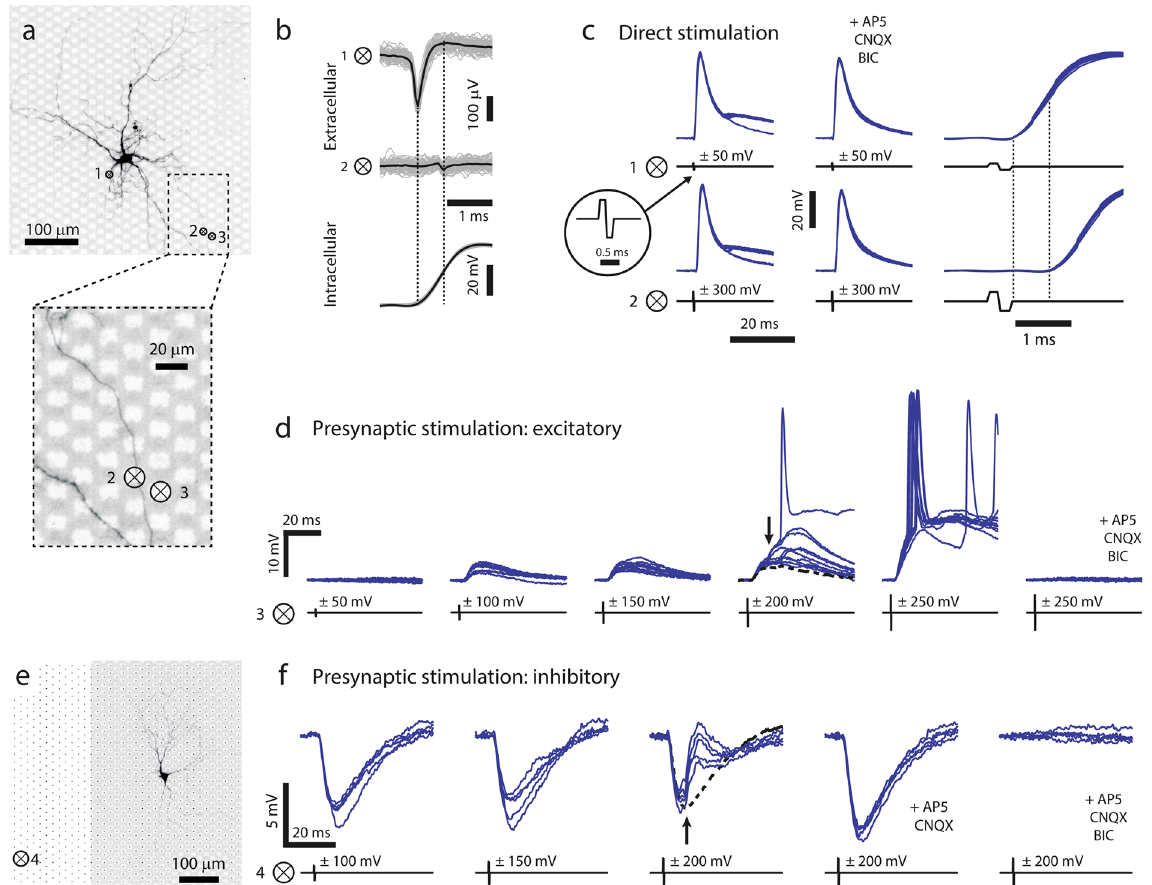
Figure 6. Evoking postsynaptic signals through HD-MEA electrical stimulation. ( a ) Fluorescence image of a neuron patched on the array, the numbered crosses inside circles “ ⊗ ” indicate positions of stimulating and/ or recording electrodes. The magnified part at the bottom shows that a neuronal process is situated on top of electrode 2 . ( b – e ) Numbered ⊗ correspond to the electrodes indicated in a. ( b ) STA extracellular traces (gray) and average trace (black), measured at electrodes 1 and 2 ( top ) and intracellularly measured AP ( bottom ). Note differences in spike shape and the temporal delay between the waveforms at electrodes 1 and 2 . ( c ) Left: Intracellular responses (blue traces, 10 trials each) to extracellular stimulation at electrodes 1 and 2 under control conditions. The stimulus timing is indicated by the black traces, and the inset shows a single biphasic voltage pulse. All stimuli evoked APs, some stimulation trials also evoked PSPs, which overlapped with the APs. Center : Responses in the presence of synaptic blockers, where no PSPs were evoked. Right : Zoom-in on responses under control conditions to better visualize the delay between stimulus end and AP onsets (depicted by the dashed lines). Also note the difference in stimulus amplitude required to elicit an action potential through electrodes 1 and 2 . ( d ) Stimulation with voltage pulses of increasing amplitudes. APs of a presynaptic neuron were evoked with stimulation voltages of ± 100 and ± 150 mV leading to PSPs. Increasing the voltage to ± 200 mV resulted in additional PSPs for some trials (indicated by the black arrow, the dashed black line represents the median response for ± 150 mV pulses). Yet larger PSPs were seen for ± 250 mV, along with the occurrence of postsynaptic APs in most of the trials. Addition of synaptic blockers resulted in complete blockade of evoked signals, indicating that all observed responses involved synaptic transmission. ( e ) Fluorescence image of another neuron and position of the stimulation electrode 4 . Black dots represent the positions of MEA electrodes. ( f ) PSPs upon stimulating an inhibitory presynaptic neuron were evoked by applying ± 100 and ± 150 mV at electrode 4 . An additional excitatory presynaptic neuron was evoked upon increasing the extracellular stimulus at electrode 4 to ± 200 mV (black arrow, black dashed line represents the median response for ± 150 mV). Application of excitatory blockers blocked the EPSPs at ± 200 mV, whereas additional application of BIC completely blocked all